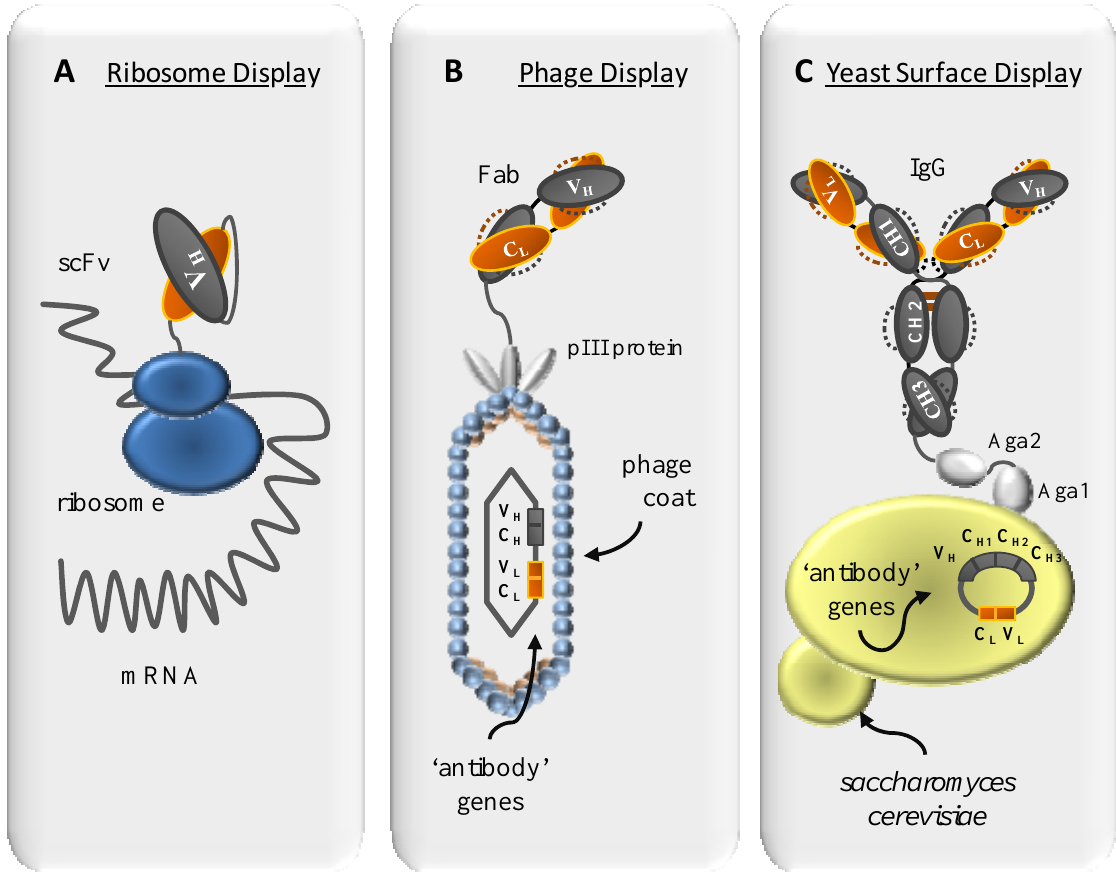
Figure 1. Display methods as tools for antibody selection. Antibody (e.g., scFv, Fab, IgG) display methods include ribosome and phage display as well as cell surface display, such as yeast display. A: Ribosome display; in vitro evolution and selection method for scFv fragments. B: Phage display; protein selection method, where antibody derived fragments are genetically fused to pIII phage-coat protein and presented on the surface of filamentous phage. C: Yeast display; cell surface selection method, capable of presenting full length IgGs. The a-agglutinin yeast adhesion receptor, composed of two proteins Aga1 and Aga2, is used to display recombinant proteins on the surface of S. cerevisiae